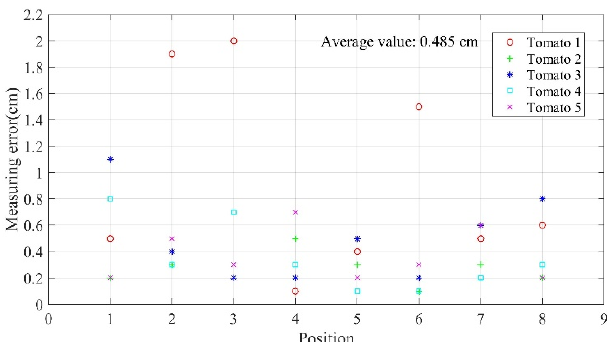
Figure 22. Scatter diagram of errors in distance measurement of tomatoes at different locations.